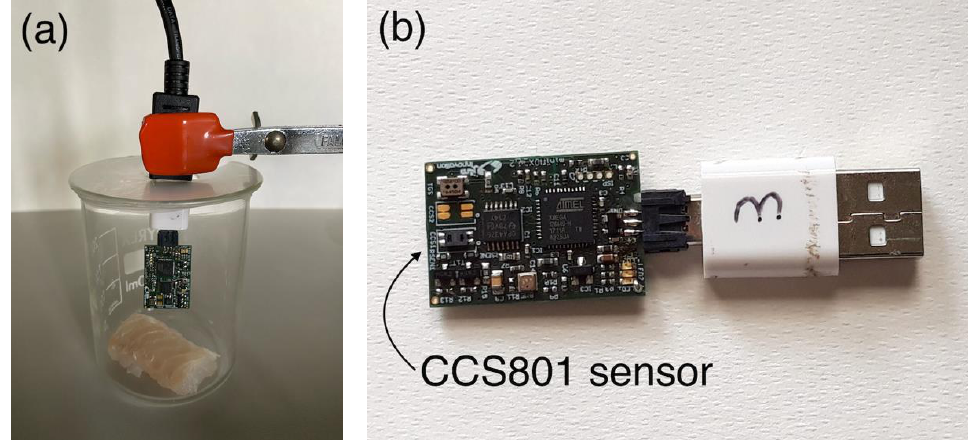
Figure 1. Measurement setup ( a ). The sensing system is lodged inside a beaker containing the target sample. Picture of the sensing system device ( b ).